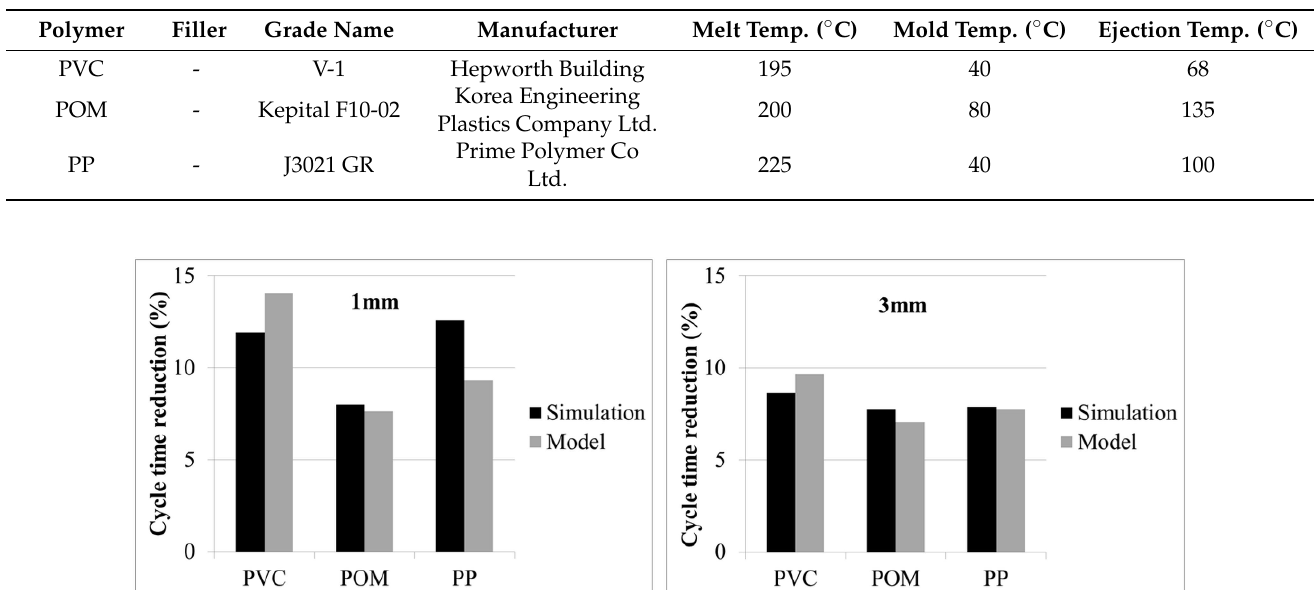
Figure 10. Comparison of part temperature from experiment and simulation for a PP for a 1 mm box on a diagonal line from the center of the part to one corner.